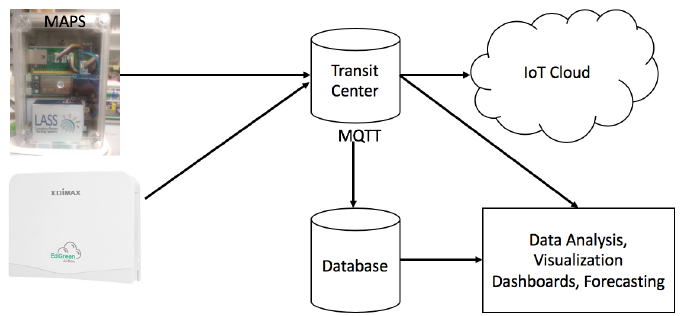
Figure 2. Flowchart for PM2.5 Sensing Framework.